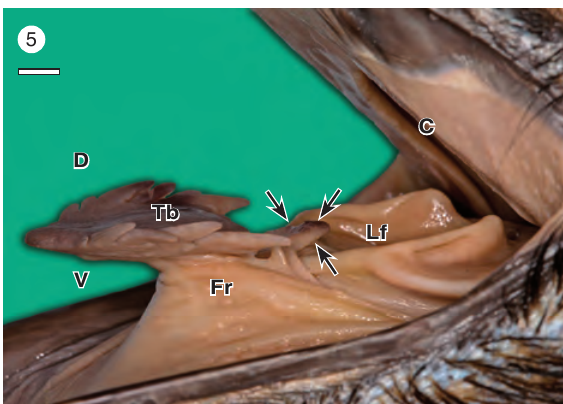
FIG. 5 The dorsoventrally flattened tongue body (Tb) shown in lateral profile. The folds of the frenulum (Fr) are not visi­ ble as the tongue body is in the raised position. Dorsum (D), ventrum (V), tongue root tip (arrows), laryngeal fis­ sure (Lf), choana (C). Bar = 5 mm